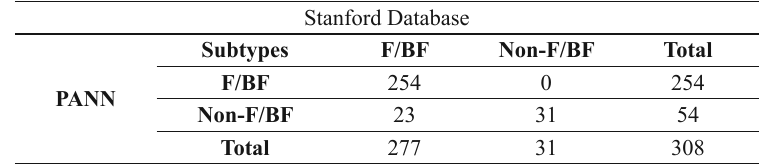
Comparison of f and Non-f subtypes of HIV-1 sequences between Stanford and PANN.